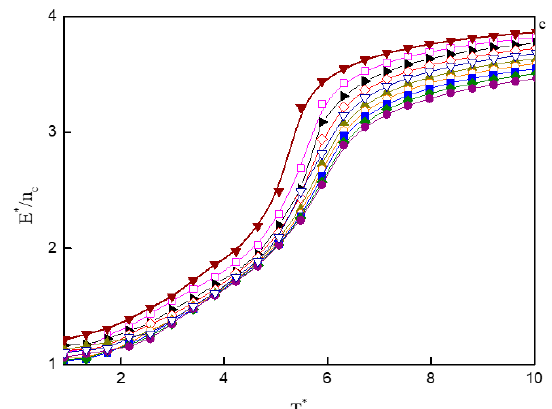
Figure 7. Temperature dependencies of selected properties for a series of copolymer volume fractions, ϕ , from computer simulations: ( a ) specific heat, C V ; ( b ) mean-squared radius of gyration, R 2 g ; ( c ) reduced energy per chain, E . n c ∗